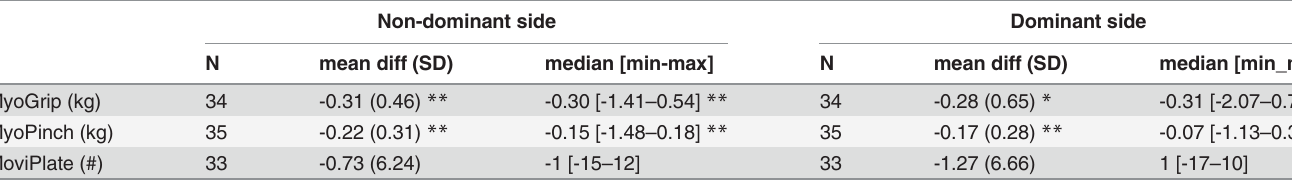
Table 5. Differences in MyoSet scores between baseline and one